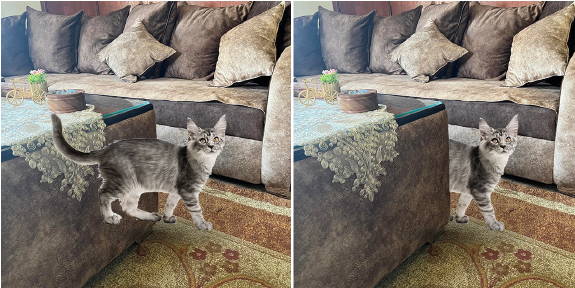
Figure 1. Demonstration of the occlusion effect. ( left ) Occlusion disabled. Occlusion enabled ( right